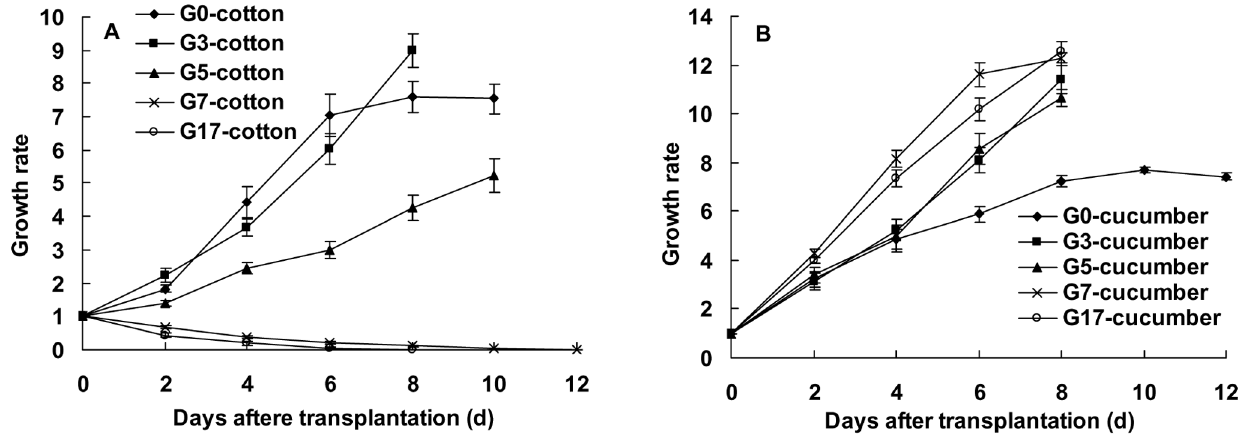
Figure 5. Growth rates of the cotton-specialized aphids on cotton (A) and the cucurbits-specialized aphids on cucumber (B). The transferred aphids were reared for zero, 3, 5, 7, and 17 generations (G0–G17) on zucchini. Bars are means 6